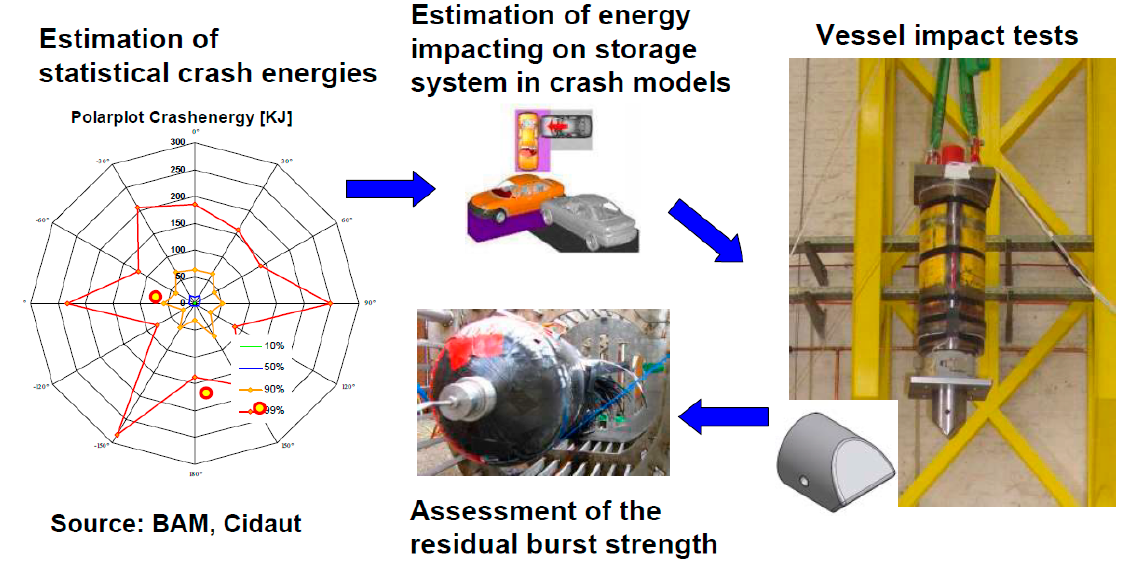
Figure 23. The procedures tailored to the specific requirements and operating conditions of the vessel [106].